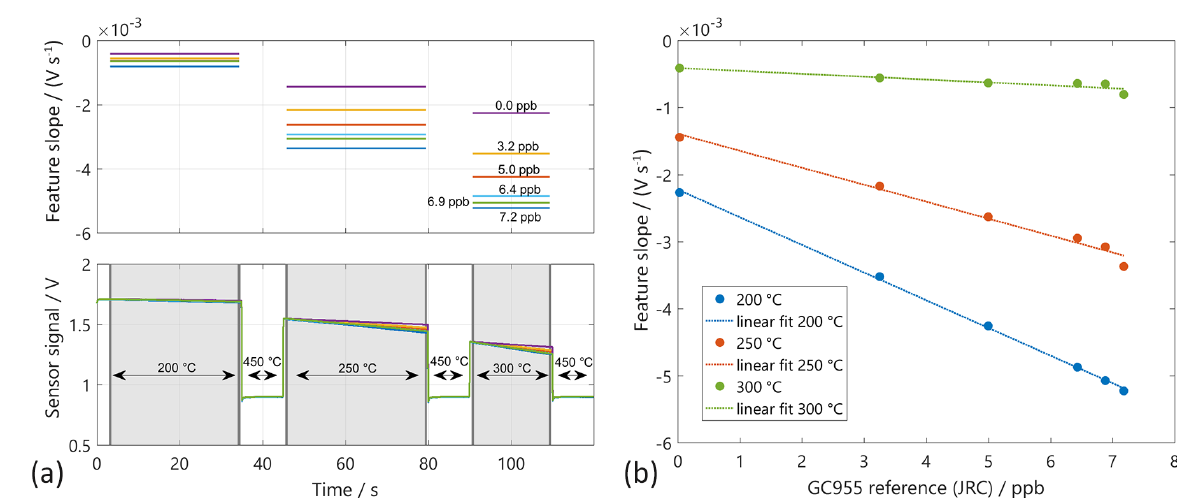
Figure 3. (a) Sensor signals in temperature-cycled operation (temperature ranges: blue arrows). The relaxation constants (slope feature) are calculated from the grey marked domains. (b) Feature slope over benzene concentration according to the GC955 reference